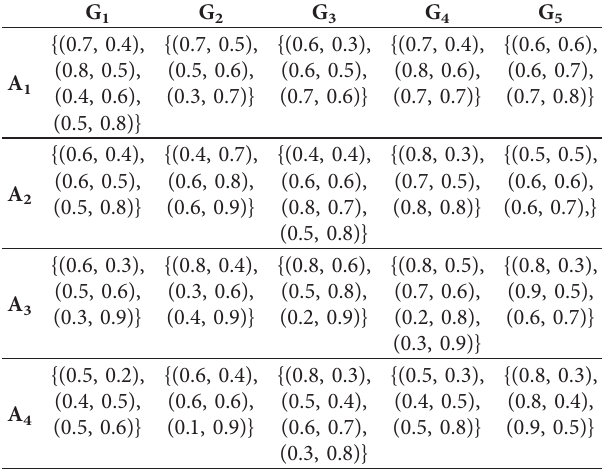
Table 1: Initial hesitant fuzzy decision matrix with credibility.